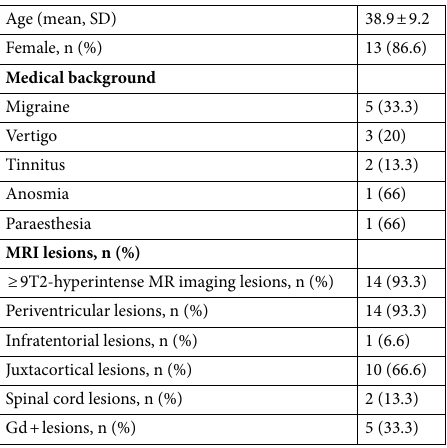
Table 1. Summary of RIS subjects’ baseline characteristics ( n = 15). Data in mean ± standard deviation and percentages. RIS radiologically isolated syndrome, MRI magnetic resonance